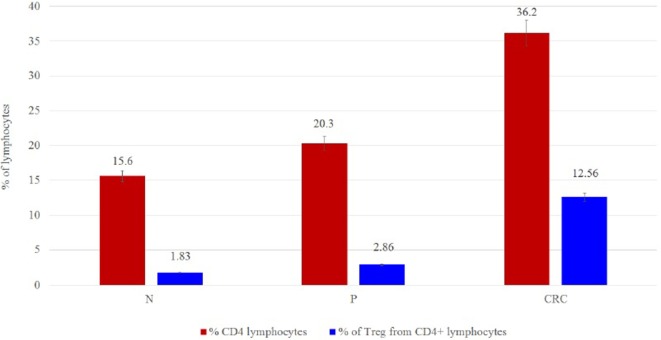
(A) Frequency cell counts and percentage of Tregs per 100,000 lymphocytes for N (n = 15), P (n = 15), and CRC (n = 15) samples. The values are given as mean value ± SD, p ≤ 0.05. (B) Percentage of Tregs from lymphocytes.